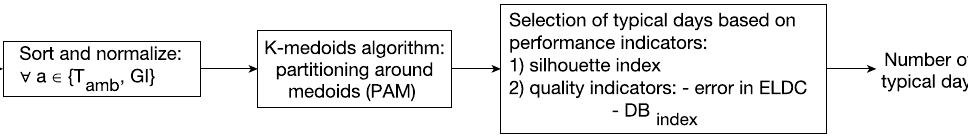
Figure 10. Typical days